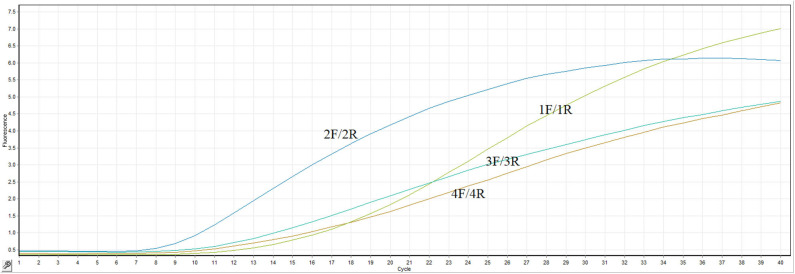
Primer sets screening. Four primers pairs were evaluated by the probe-based RT-RPA assay.